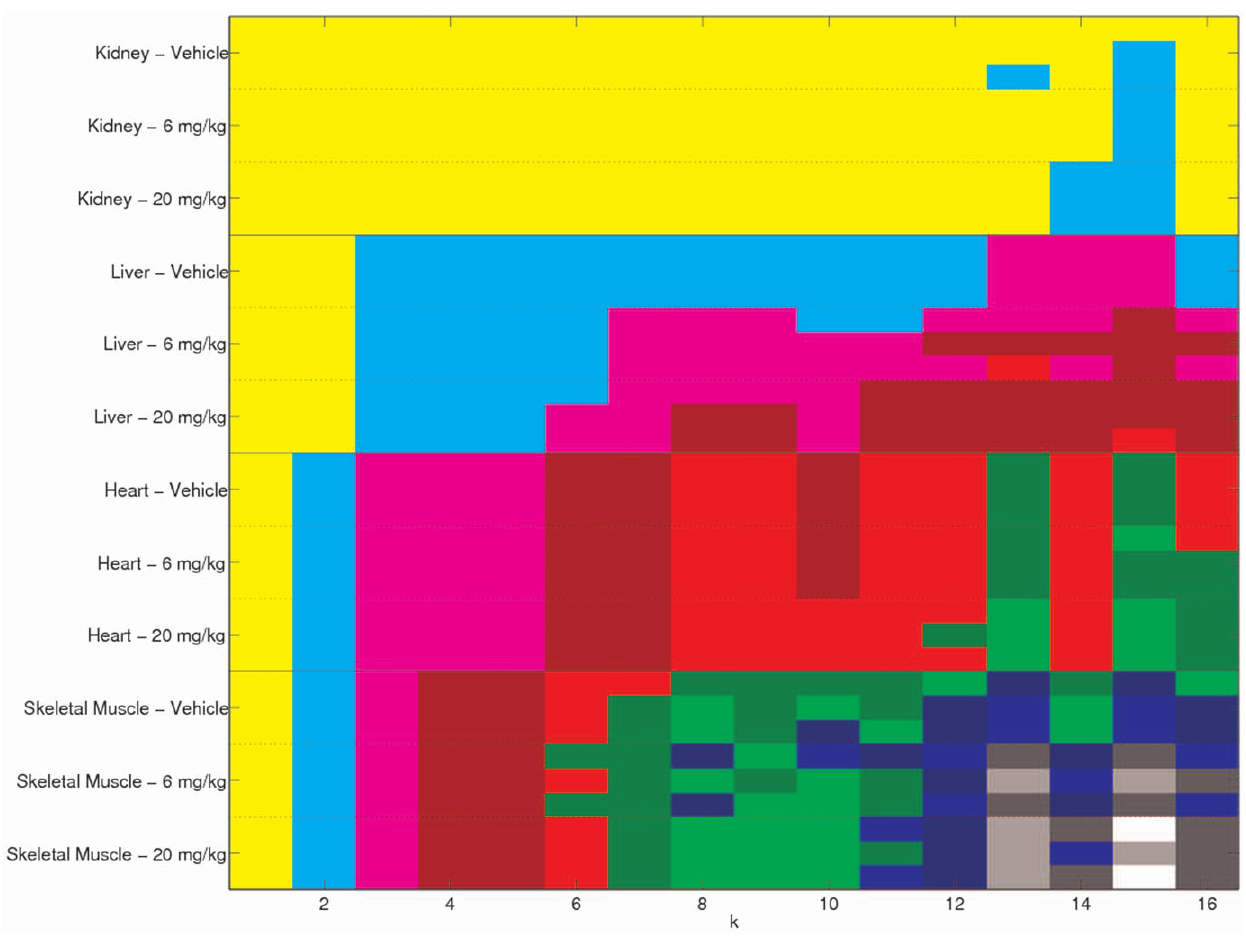
Figure 3. Factorising as a single dataset. The clustering of the mouse samples for k ~ 1, ... ,16 . Within each column the samples in the same colour are clustered together. No value of k reveals the known tissue/dosage subgroups, or places different tissues in the same cluster.